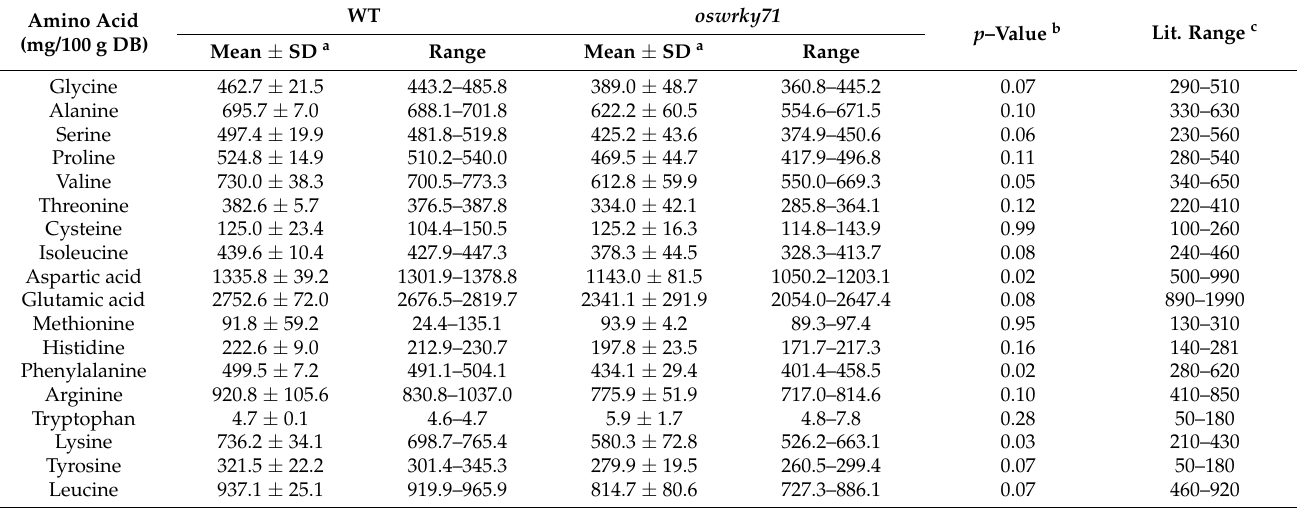
Table 3. Comparison of the amino acid composition of threshed rice grain.